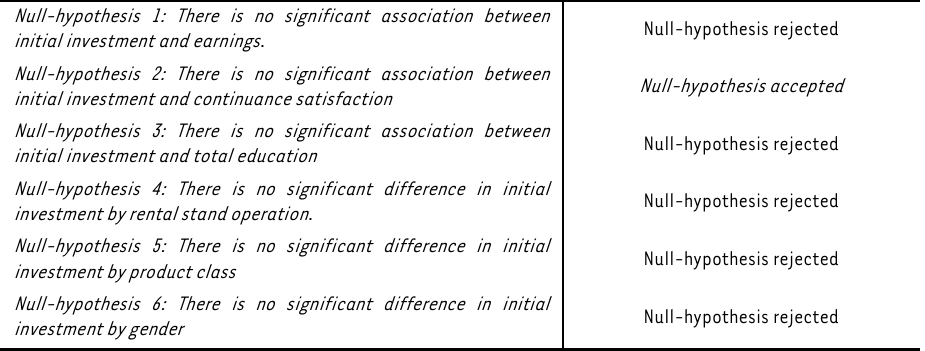
The results of the testing of the